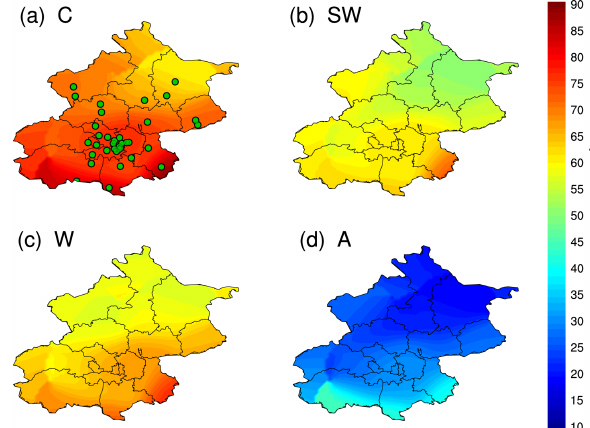
Figure 4. The averaged PM 2 . 5 concentration (shaded; units: 10 − 1 µgm − 3 ) in Beijing for types C (a) , SW (b) , W (c) , and A (d) from 2018 to 2019. The green dots in Fig. 4a indicate the locations of air quality monitoring sites in